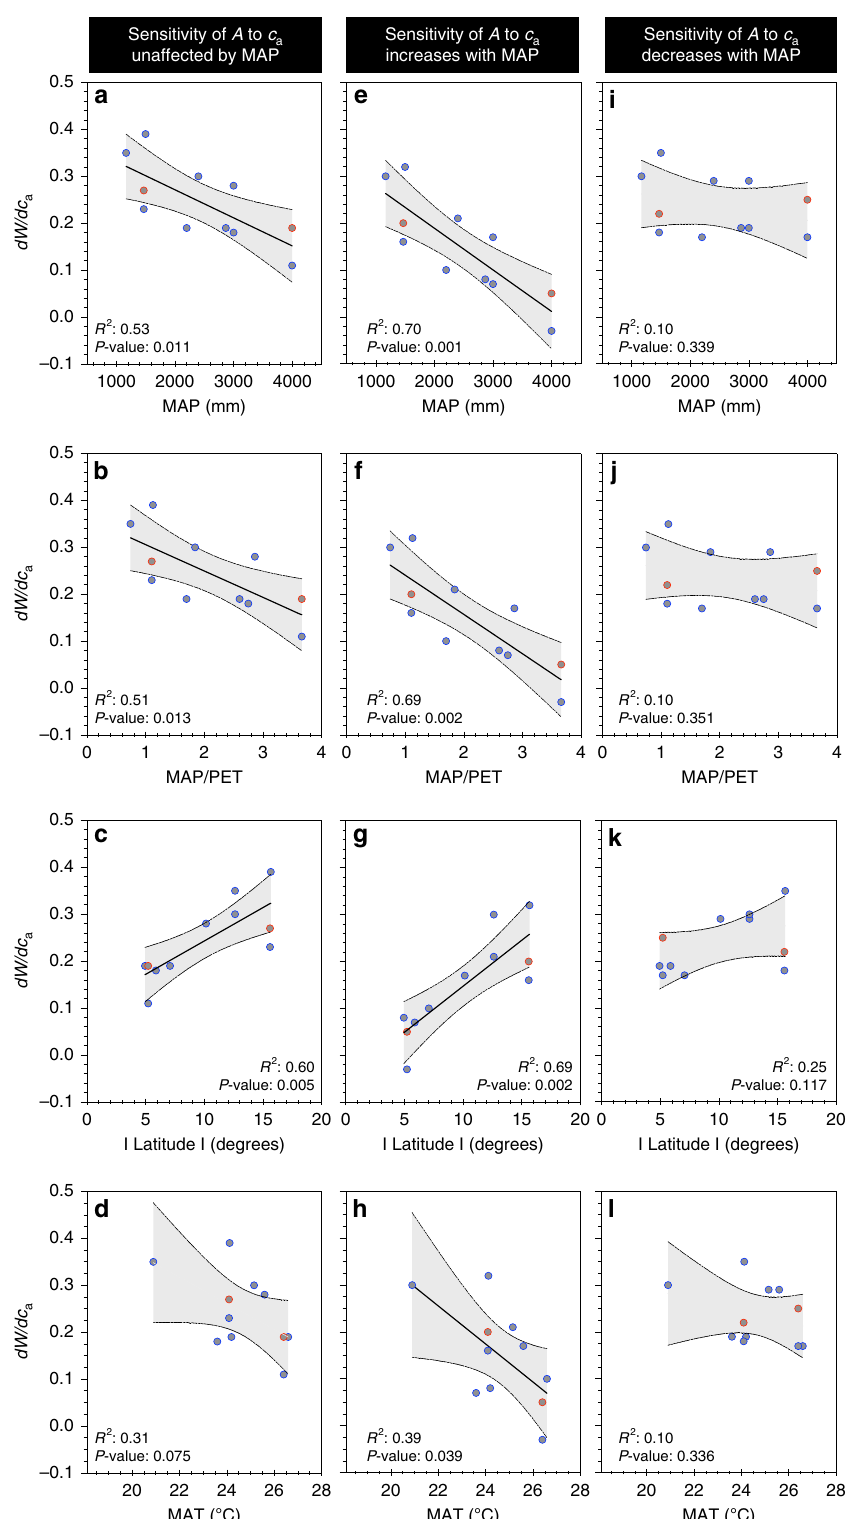
Fig. 3 Modelled effects of physiology on rates of change in W . Effects of methods for computing intrinsic water-use ef fi ciency ( W ), and modelled sensitivity to mean annual precipitation (MAP) of the A/c a response to c a (where A is net photosynthesis and c a is atmospheric [CO 2 ]) for relationships of dW / dc a (change in W per unit c a ) to: MAP, the ratio of MAP to potential evapotranspiration, absolute latitude and mean annual temperature (MAT). a – d W includes terms to account for mesophyll conductance and photorespiration. e – h as for a – d but A/c a response to c a increases with MAP, ( i – l ) as for a – d but A/c c a response to a decreases as MAP increases. The data are site averages from sources as described in Figs. 1 and 2. See the Methods section for further